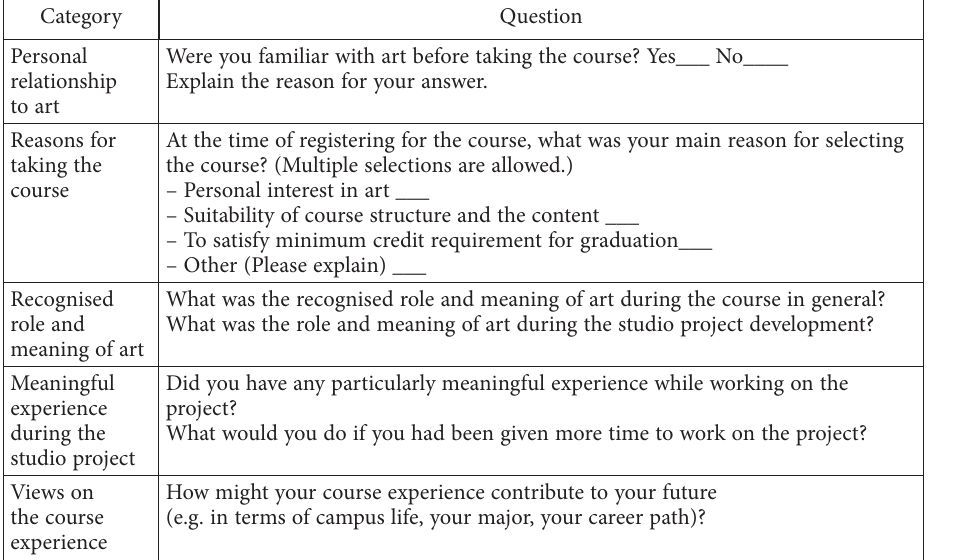
Table 5. Post-class survey questionnaire (source: created by